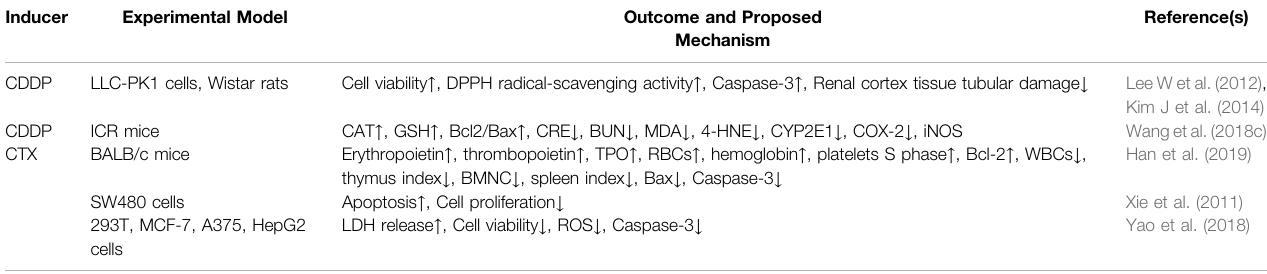
TABLE 5 | Summary anti-cancer effects of Re.